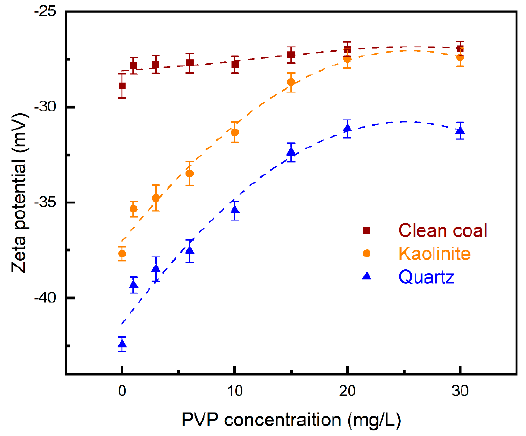
Figure 7. Zeta potentials of clean coal (wine), kaolinite (orange), and quartz (blue) with different PVP concentrations.